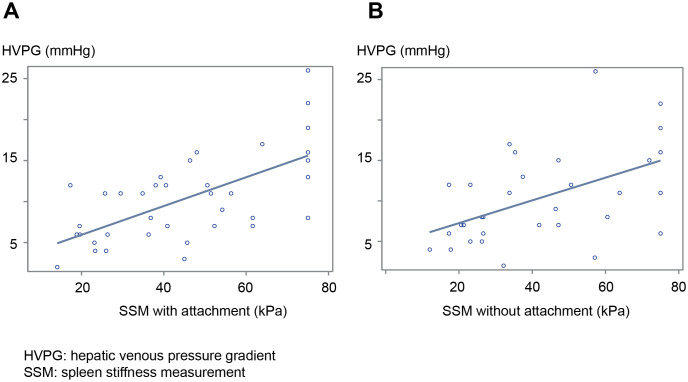
SSM with and without the new device linearly correlated with HVPG.A) SSM with the new device, B) SSM without the new device. SSM = spleen stiffness measurement, HPVG = hepatic venous pressure gradient.